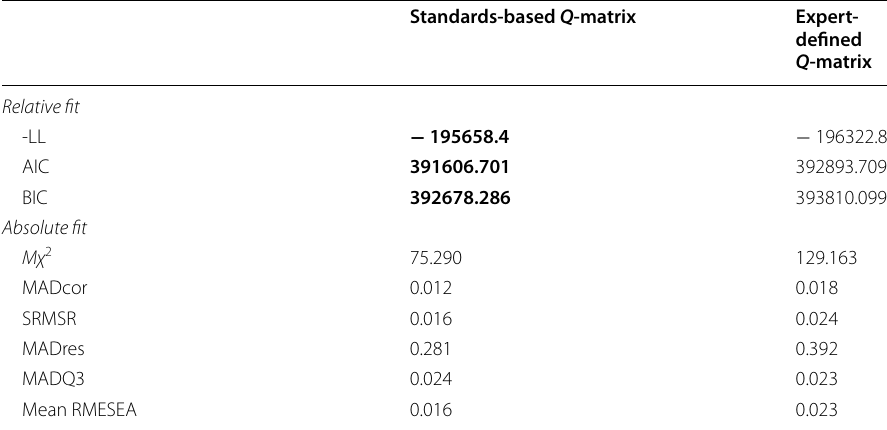
Table 8 Comparison between the expert-defined and standards-based Q